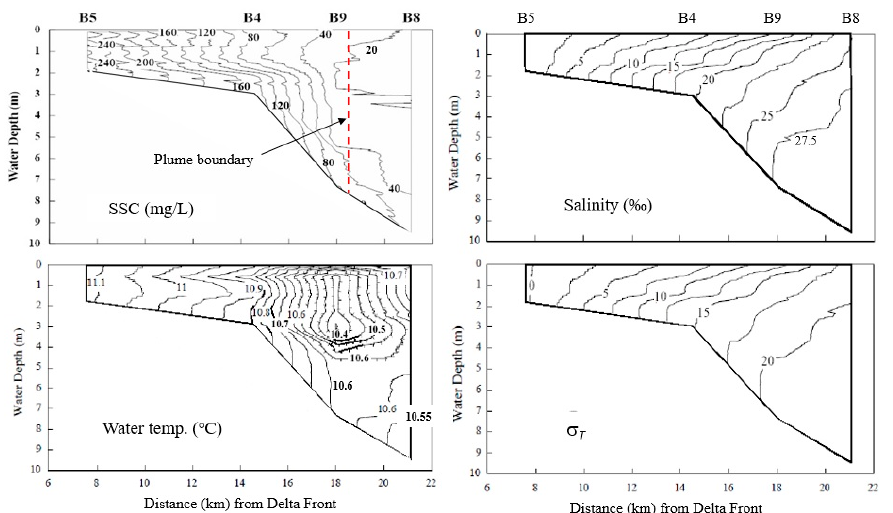
Figure 4. Longitudinal cross-sections of SSC, water temperature, salinity, and water density σ T by the coastal observation on the B5–B8 line on 6 September 2009 (Figure 1). The dotted line in the SSC cross-section shows a boundary between turbid plume water and relatively clean ocean water observed in situ.